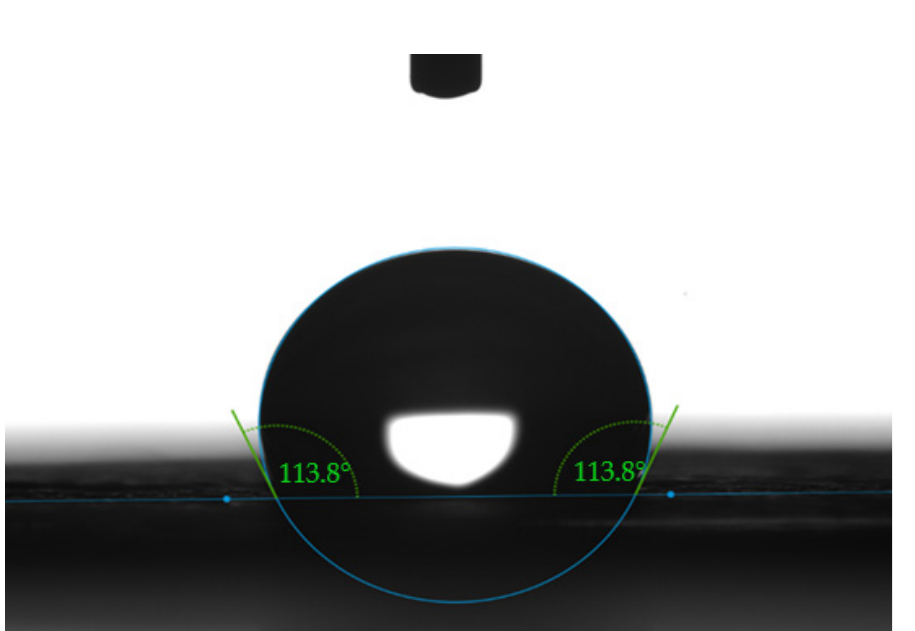
Figure 2. Example of an image from the measurement of the water contact angle in ADVANCE software (version 1.9).